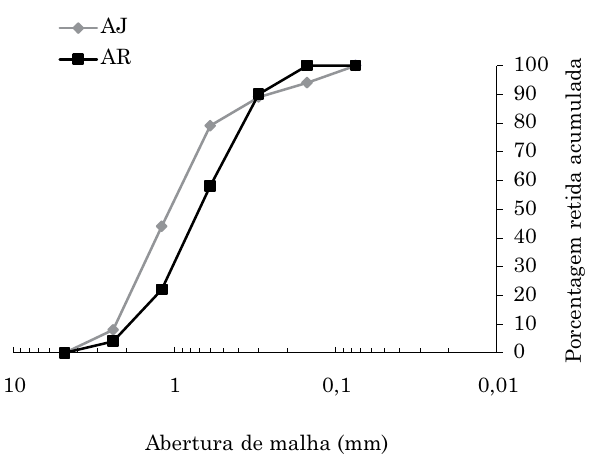
Figura 5. Curvas granulométricas empregadas para calcular a esfericidade média da areia do cordão litorâneo (AJ) e da areia de rio (AR).